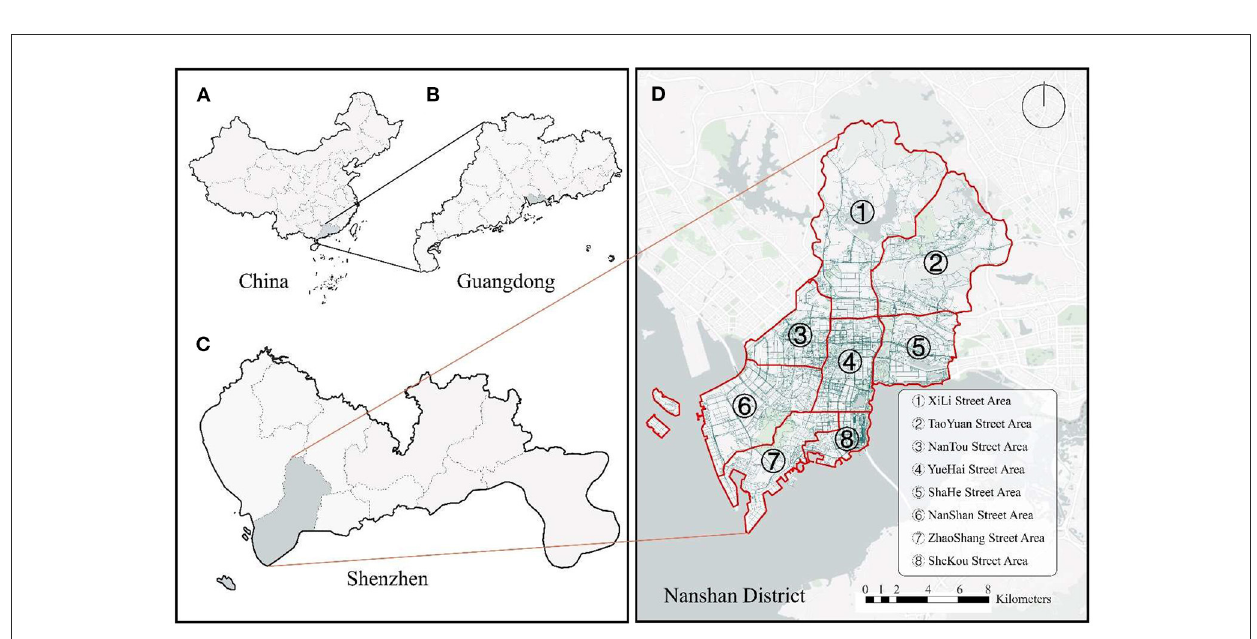
FIGURE2 Study area (Nanshan District, Shenzhen, China): (A) China; (B) Guangdong Province; (C) Shenzhen; (D) Nanshan District.